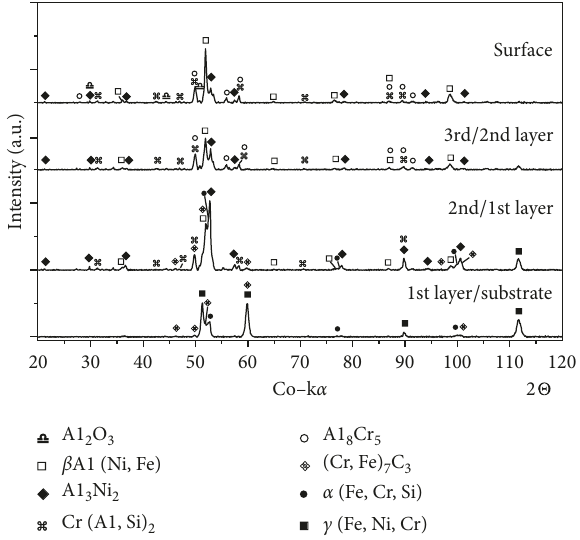
Figure 11: A simplified model of the coatings. Effect of the silicon content in the slurry on the phase composition of the coatings.